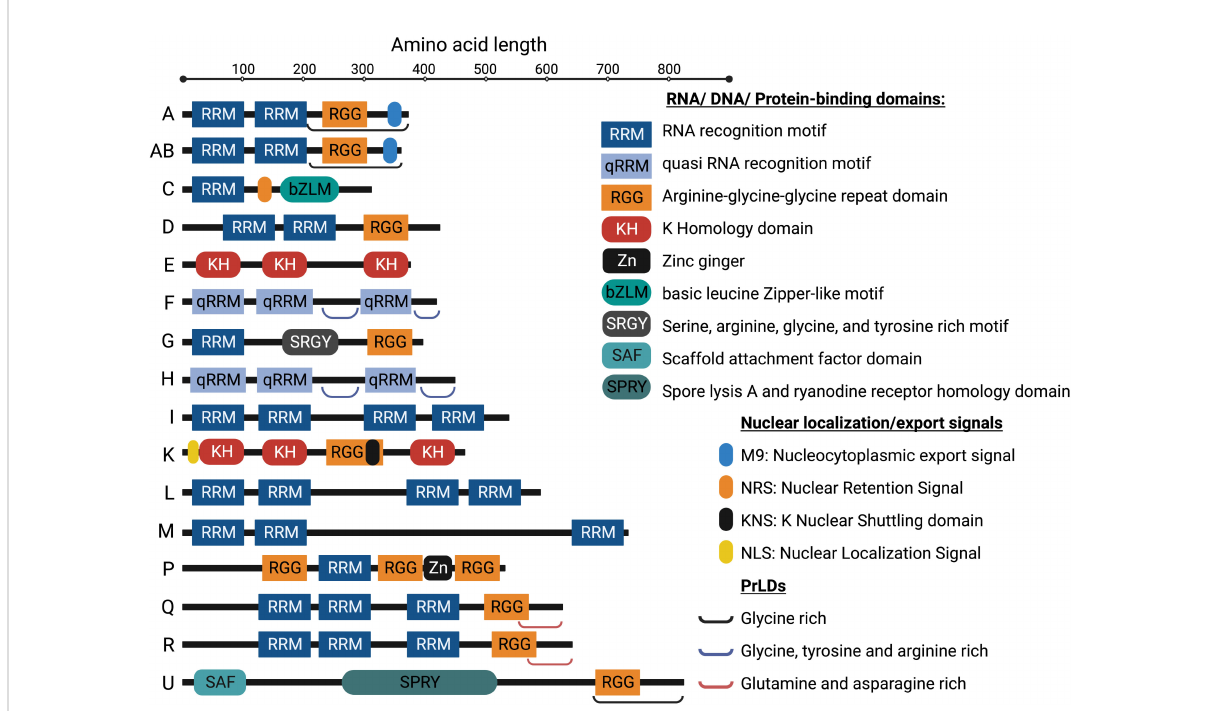
FIGURE 1 Schematic diagram of structures of the representative isoforms of the major hnRNP proteins. PrLDs, Prion-like domains (aka intrinsically disordered regions (IDRs)). The image was created with